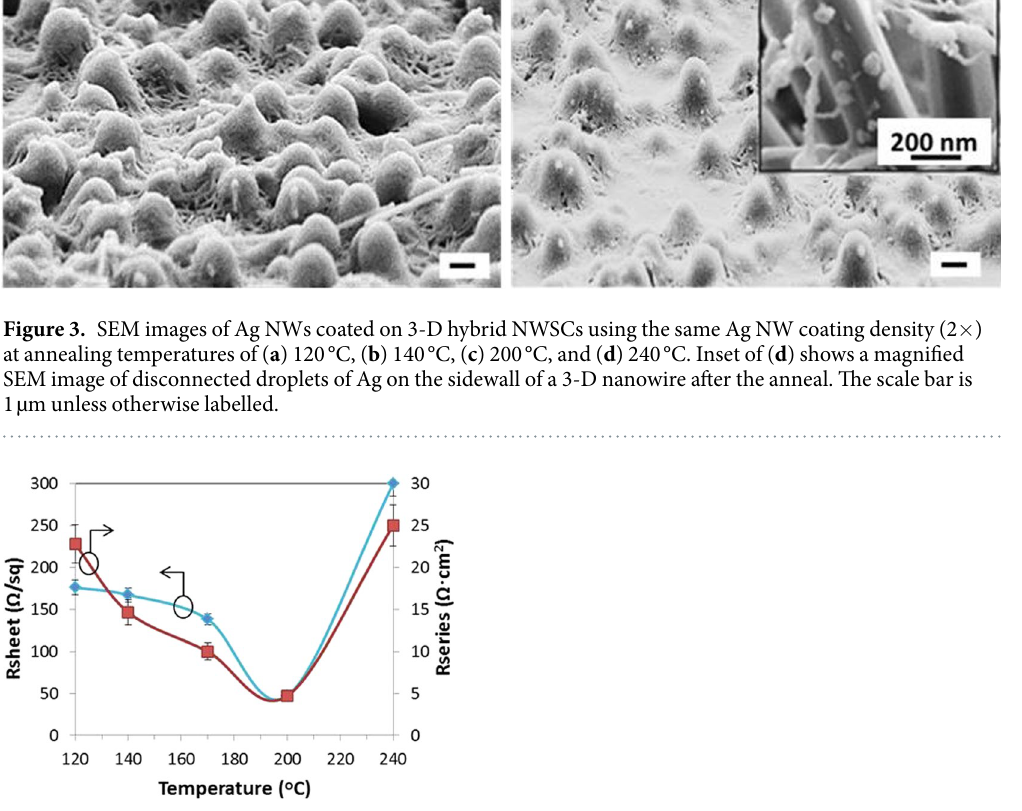
4 Scientific REPORts | 7: 8916 | DOI:10.1038/s41598-017-07180-1